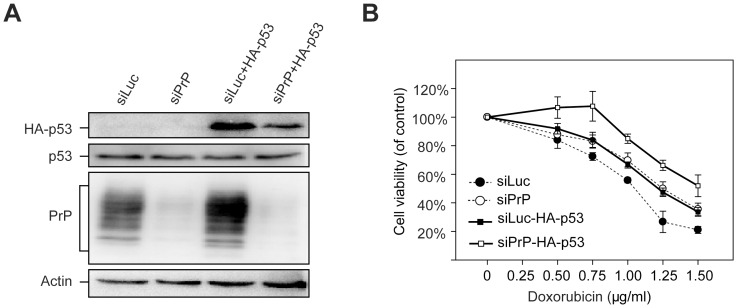
Effects of p53 on doxorubicin-induced cytotoxicity in siLuc and siPrP cells.(A) Immunoblot analyses of transfected wild-type HA-p53 expression (anti-HA antibody), total p53 expression (anti-p53 antibody), and PrP expression (anti-PrP antibody). Immunoblot analysis of actin was performed to verify the total input of cell lysates. (B) After incubation with doxorubicin for 48 hours at indicated concentrations, cell viability was measured by the MTT assay. Differences between siLuc with siPrP were statistically significant (p<0.5, student's t test) at doxorubicin concentrations of 0.75, 1.00, 1.25 and 1.50 µg/mL. Differences between siLuc-HA-p53 with siPrP-HA-p53 were statistically significant (p<0.5, student's t test) at all doxorubicin concentrations.